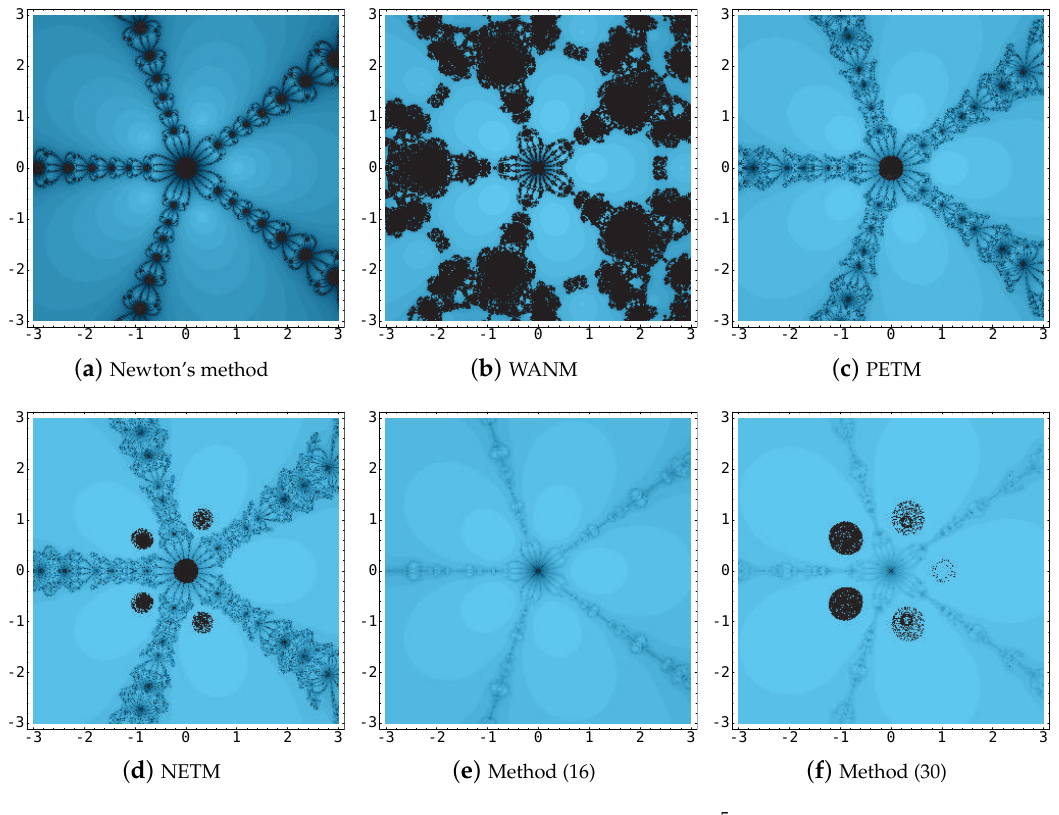
Figure 4. The results are for the polynomial z 5 − 1.